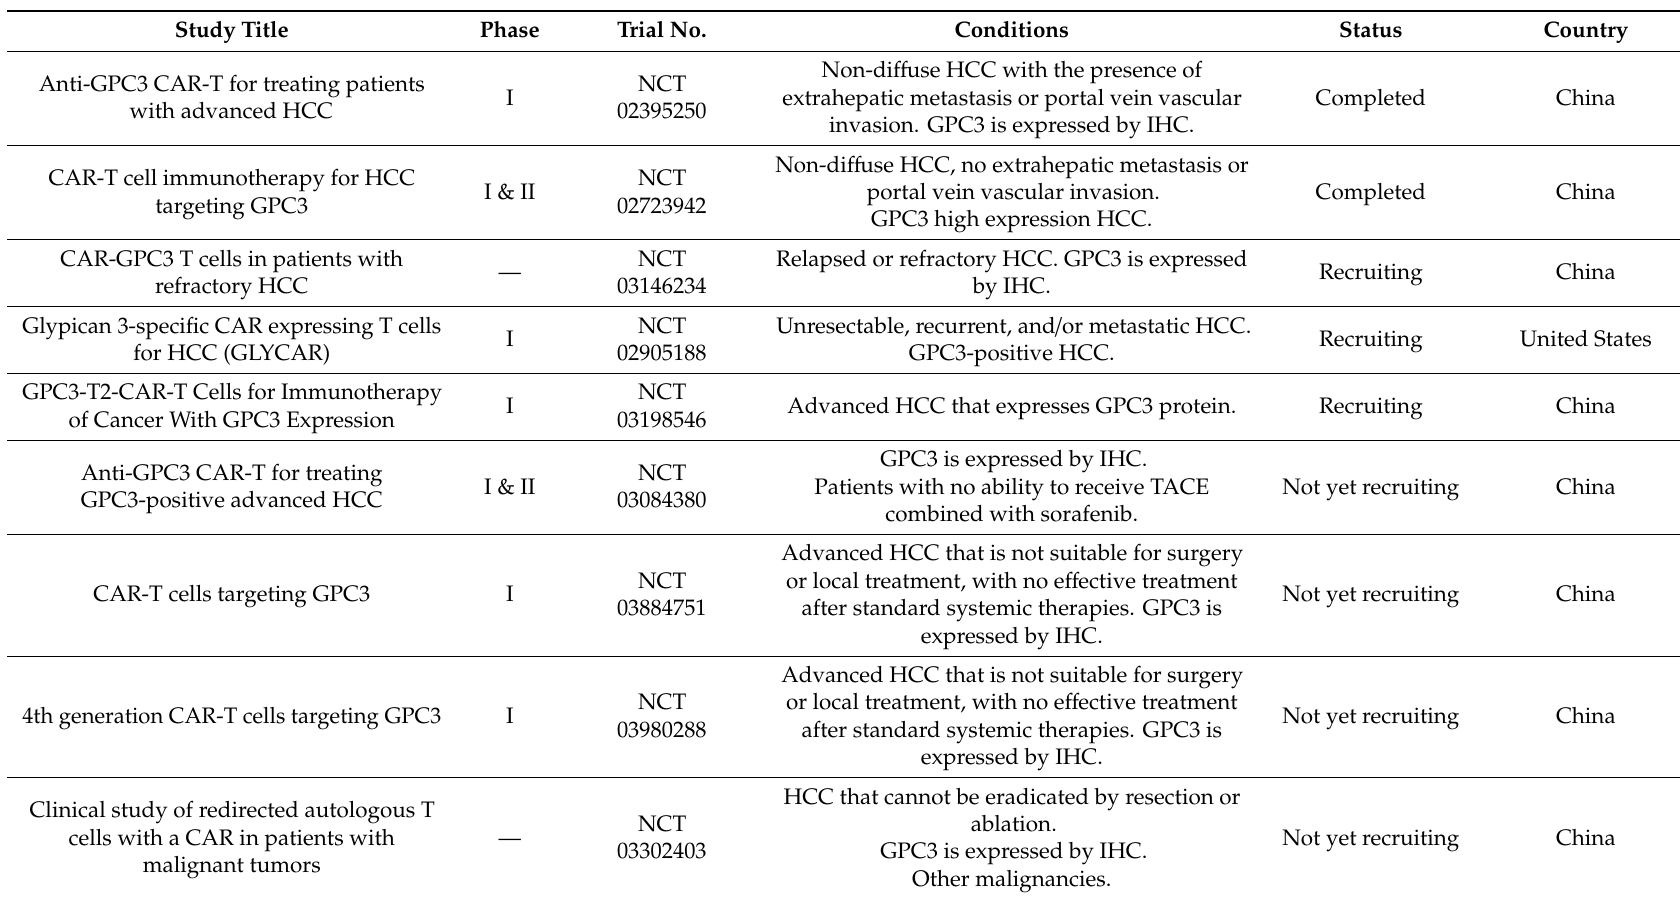
Table 2. Ongoing or planned GPC3-targeted chimeric antigen receptor (CAR)-T therapy studies in